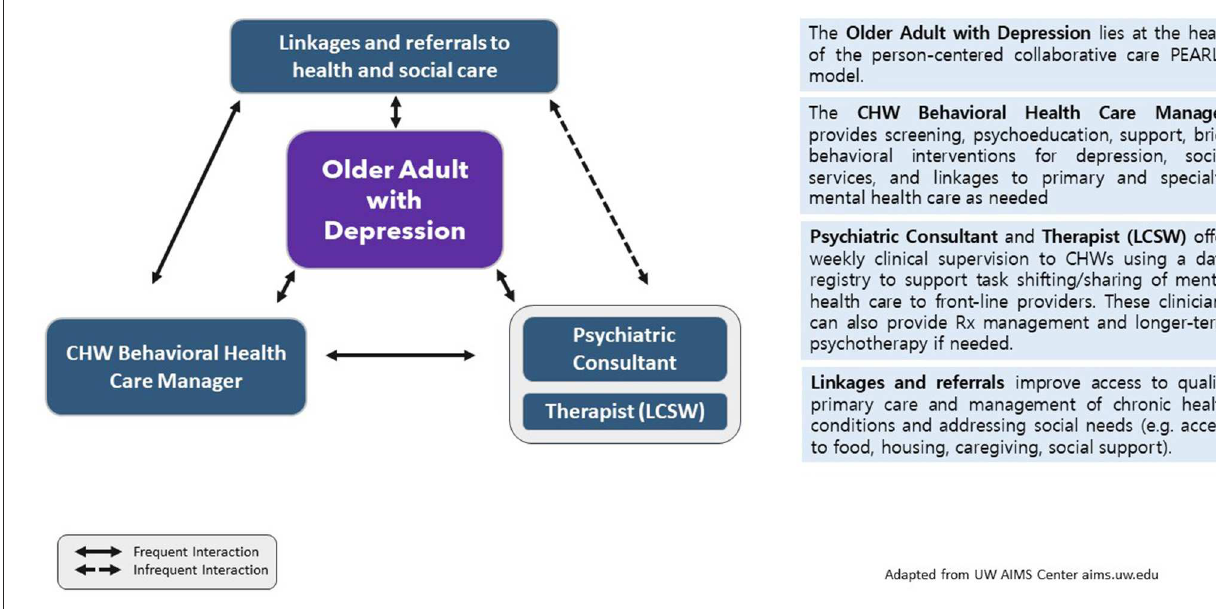
FIGURE1 Model for adaptation design and impact: modified for PEARLS via CHWs/Ps for older Latino adults a . a Modified from Kirk et al. (55) MADI framework.